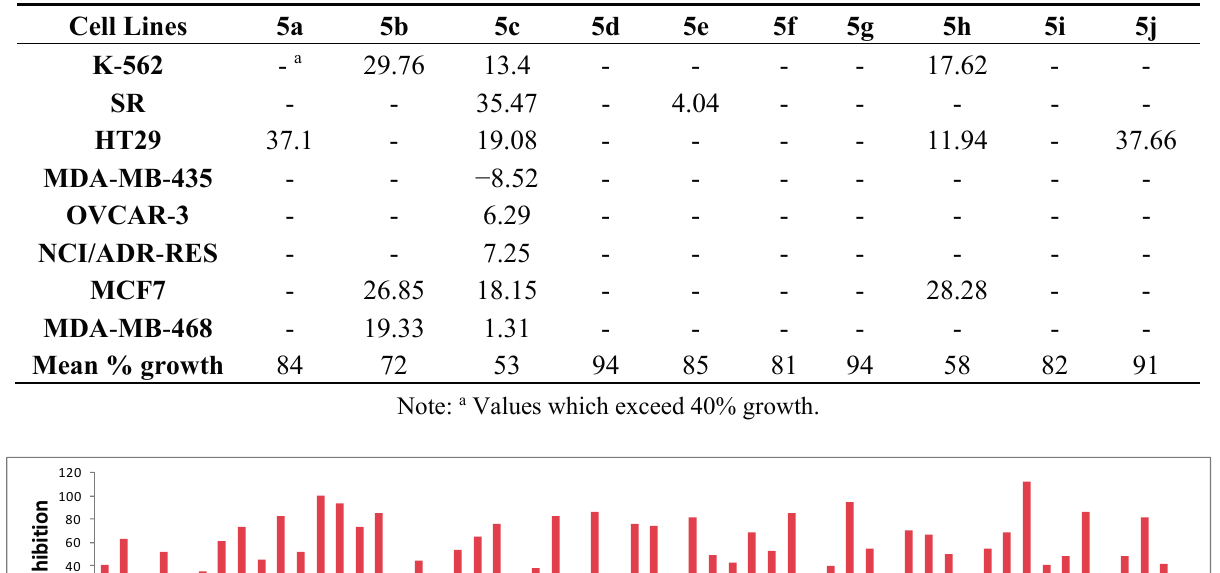
Table 2. Screening data of the tested compounds with the most sensitive cell lines and mean percentage growth.